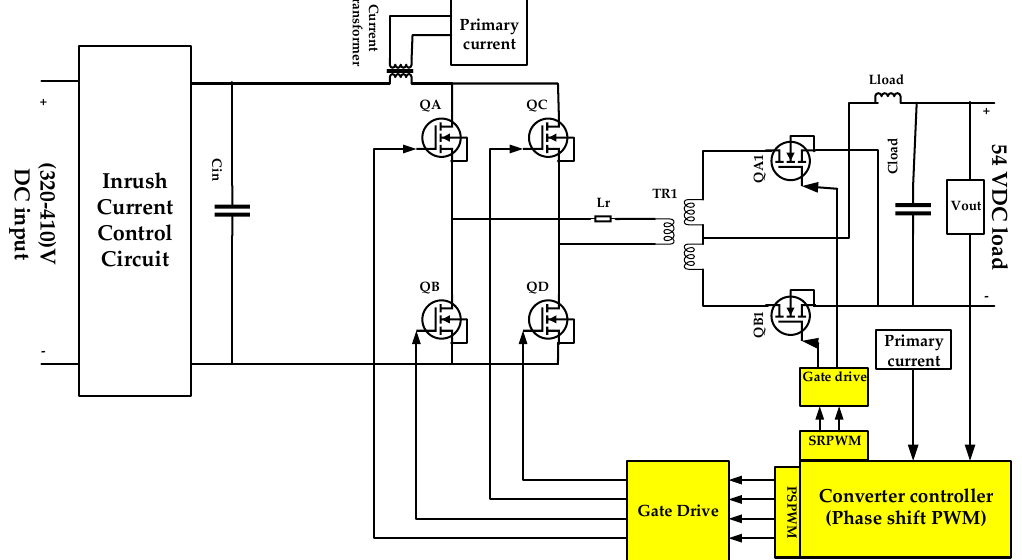
Figure 2. Schematic diagram of DC–DC phase shift ZVS converter with the proposed inrush current control.